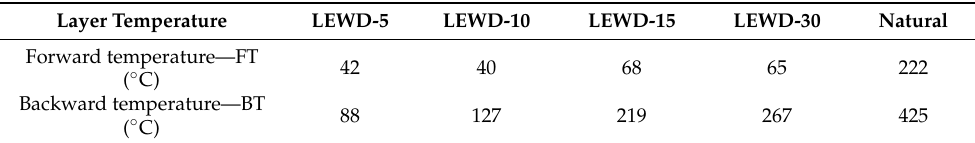
Figure 10. Effect of the LEWD parameter on the thermal features measured with the trailing/leading IR pyrometer in the 350 mm-long walls. Table 4. Effect of the LEWD parameter on the average forward and backward temperatures of the 350 mm-long walls.